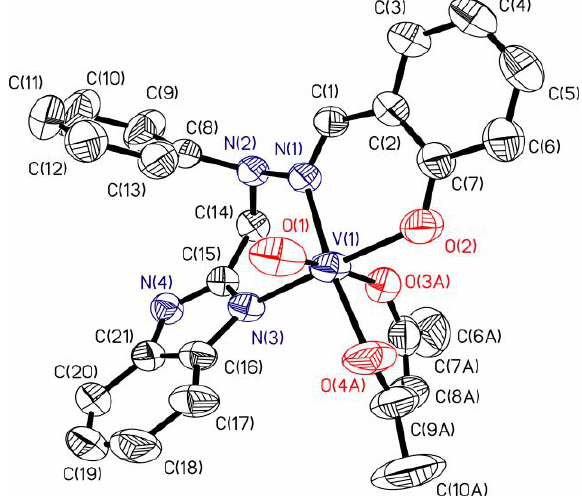
Figure 3. ORTEP of the asymmetric unit in ligand HL 1 ( I ). Non-hydrogen atoms were drawn using 50% probability ellipsoids. Hydrogen atoms were omitted for clarity. The drawing was made with the SHELXL set of programs. CCDC number: 2241272.